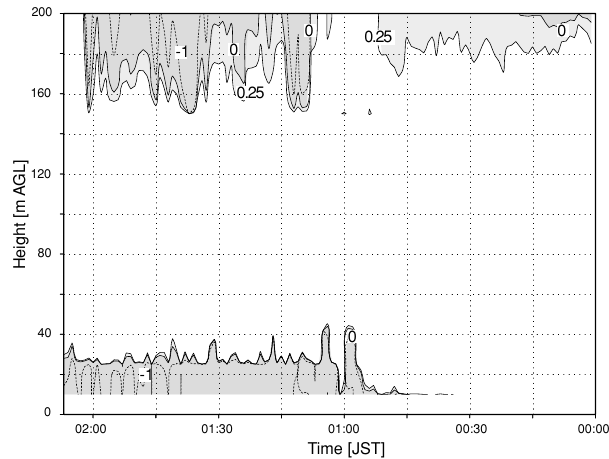
Fig. 8. Time series trace of virtual temperature ( T v ) at about 200m derived from the tower and RASS from 00:00 to 24:00 JST on 30 December 1997. The solid line represents the tower data, which has been averaged over 5min to match with RASS measurement. Open circles represent the RASS measurements. Thick lines on the bottom indicate rainy periods. The mean, standard deviation and number of samples of temperature difference are summarized in a